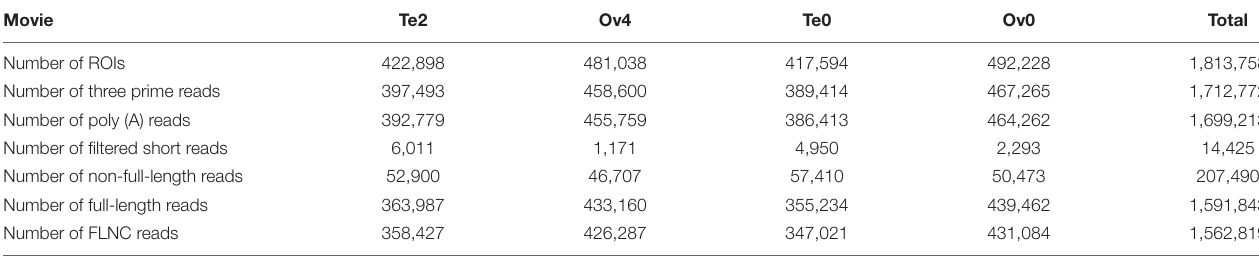
TABLE 1 | Classification of reads of insert